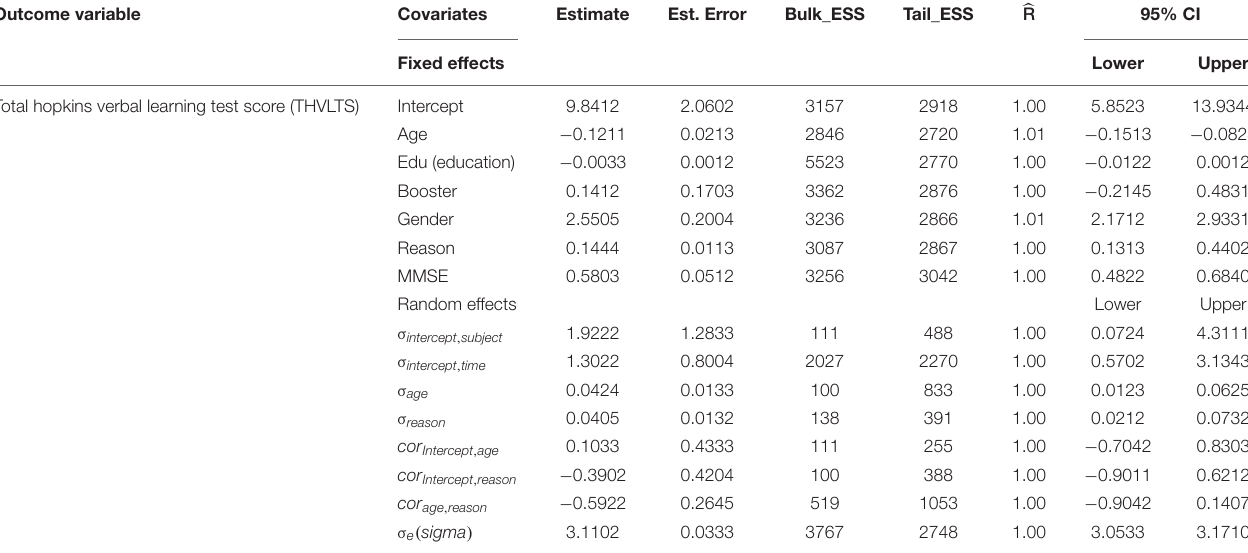
TABLE 3 | Results from the fitted varying slope mode: Model 3.